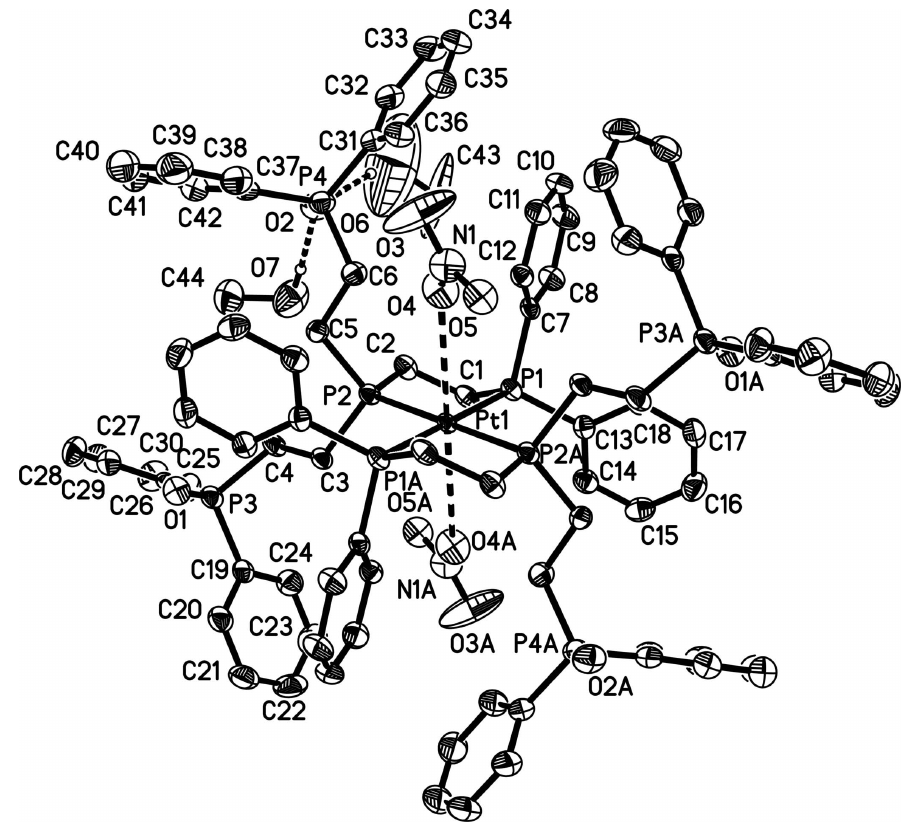
Figure 1 ORTEP representation of the Pt II complex with displacement ellipsoids at 50% probability. H atoms and labels for symmetry equivalent C atoms have been omitted for